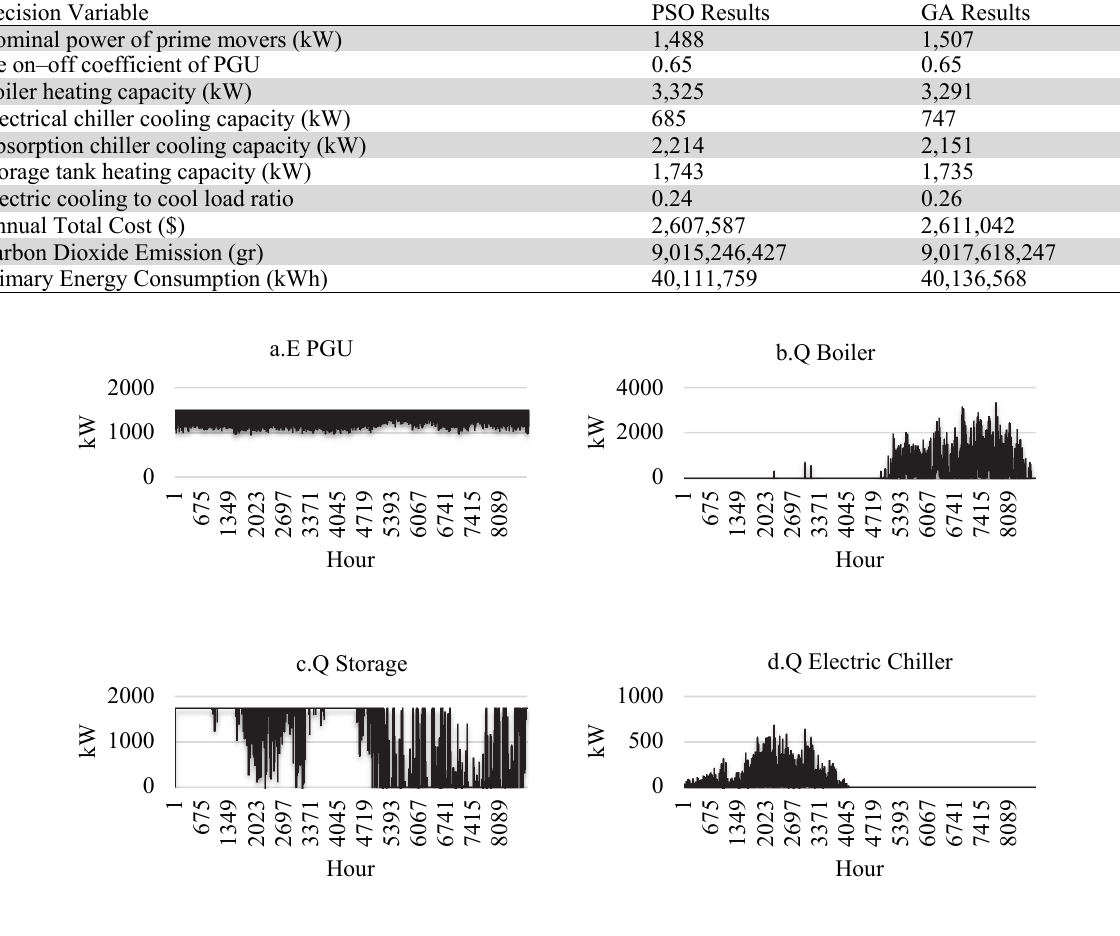
Fig. 9. Performance of system all year long (Fixed ratio of electric chiller cool load to cooling